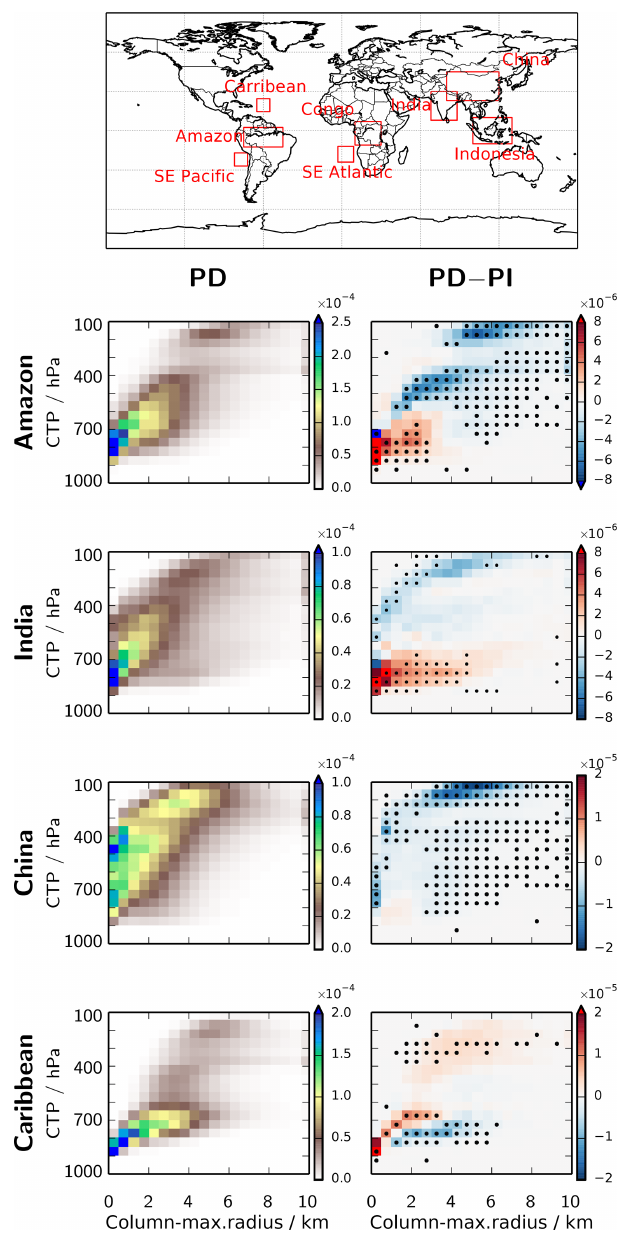
Figure 4. Response of the CCFM cloud top–radius distribution in four different regions, as shown in the map (top, along with four additional regions included in the Supplement). Note that the “In- dia” region used for analysis is restricted to the land points in the box. The left column shows the distribution under PD aerosol emis- sions; the right column shows the difference from PI aerosol emis- sions (with all effects included). The radius on the x axis indicates the broadest part of a given entraining plume in the CCFM 10- member cloud-type ensemble over its whole height. (PD: present- day aerosol; PI: pre-industrial aerosol; black dots indicate histogram bins where the PD–PI difference is statistically significant at the 95%